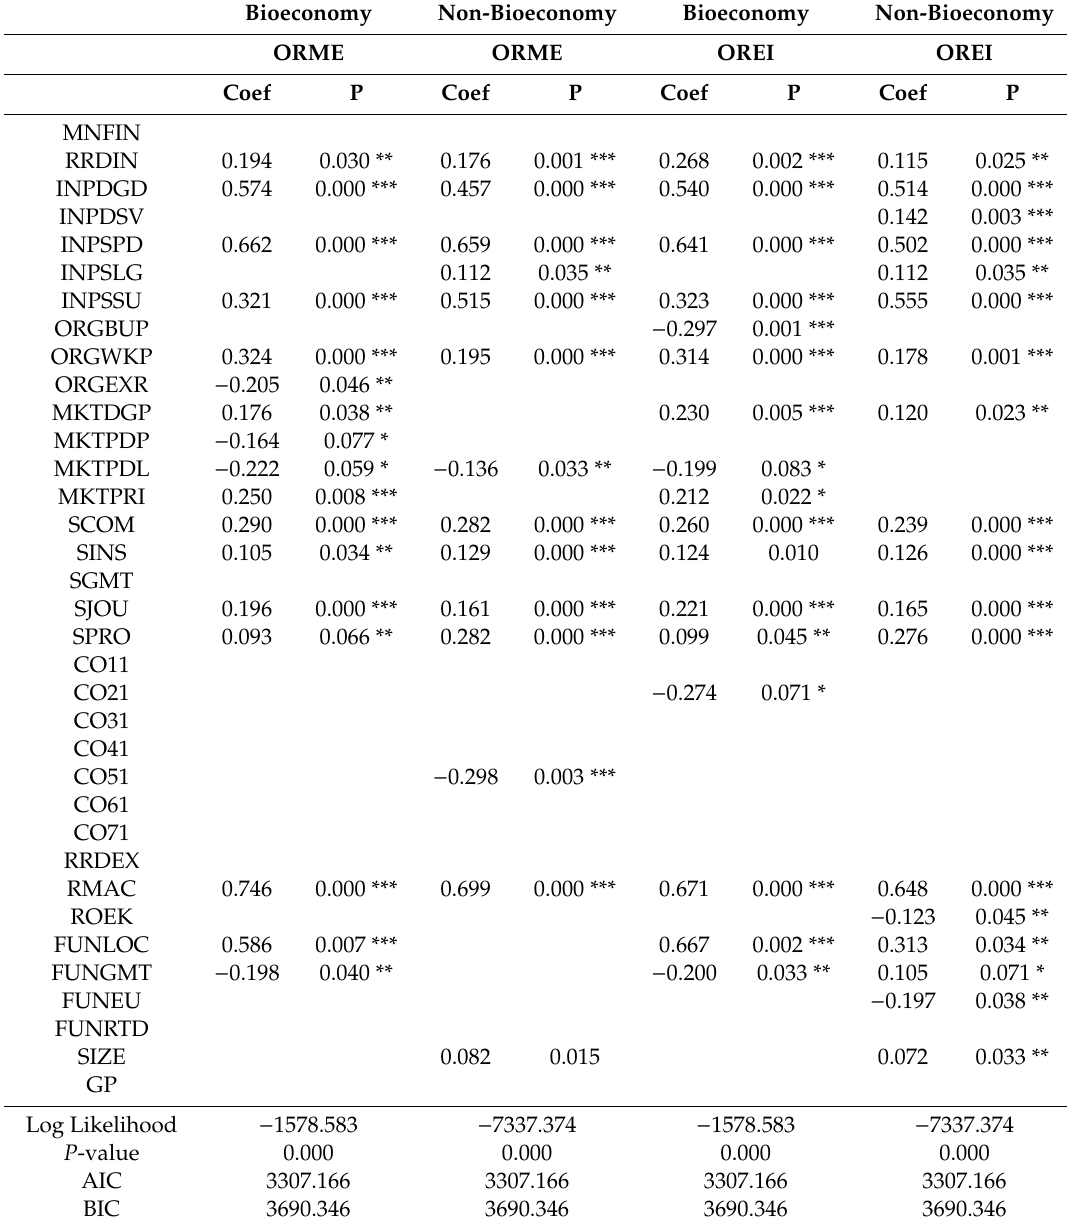
Table A7. Estimation results of multivariate tobit model